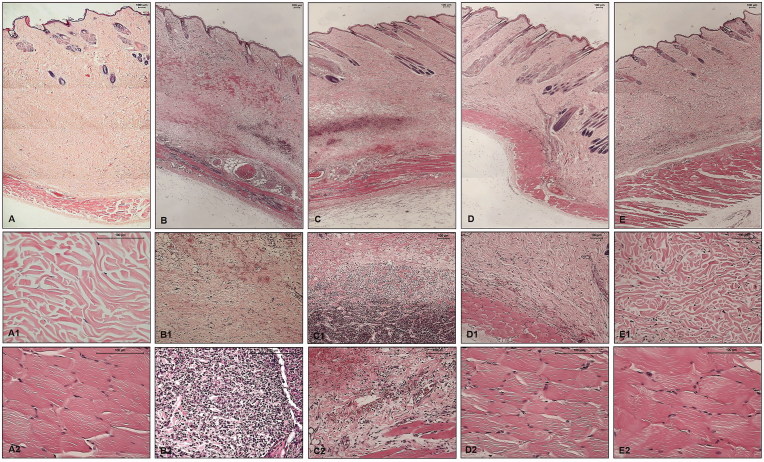
Histopathological analysis of skin fragments from rabbits inoculated with PBS, Loxosceles venom in the presence or absence of inhibitors 1, 5 or 6. Rabbit skin fragments inoculated with PBS, 5 μg of L. laeta venom in the absence or presence of inhibitors 1, 5 or 6 (1 μg), were removed 72 h after inoculation and fixed in 4% formaldehyde pH 7.4. Samples were submitted to the preparation of permanent histological slides stained with Hematoxylin-Eosin. (A) General appearance of the skin fragment inoculated with PBS (5× magnification). (A1) Detail of the collagenous area of the normal dermis (20× magnification). (A2) Detail of the normal adjacent muscular layer (20× magnification). (B) General appearance of the skin fragment inoculated with 5 μg of L. laeta venom in the absence of inhibitors (5× magnification). (B1) Detail of haemorrhagic areas and collagen disorganisation (10× magnification). (B2) Detail of the presence of dense inflammatory infiltrate in tissue (40× magnification). (C) General appearance of the skin fragment inoculated with venom in the presence of inhibitor 1 (5× magnification). (C1) Detail of the presence of inflammatory infiltrate and haemorrhagic areas in the tissue (10× magnification). (C2) Detail of the disorganisation of collagen fibres and haemorrhagic areas near the adjacent muscular layer (20× magnification). (D) General appearance of the skin fragment inoculated with venom in the presence of inhibitor 5 (5× magnification). (D1) Detail of reduced collagen disorganisation, absence of haemorrhagic areas and inflammatory infiltrate (10× magnification). (D2) Detail of the adjacent muscular layer (40× magnification). (E) General appearance of the skin fragment inoculated with venom in the presence of inhibitor 6 (5× magnification). (E1) Detail of reduced collagen disorganisation, absence of haemorrhagic areas and inflammatory infiltrate (20× magnification). (E2) Detail of the adjacent muscular layer (40× magnification). The slides were analysed and photographed using a Leica DM2500 microscope with the aid of Leica QWin Plus Y2.8 software.